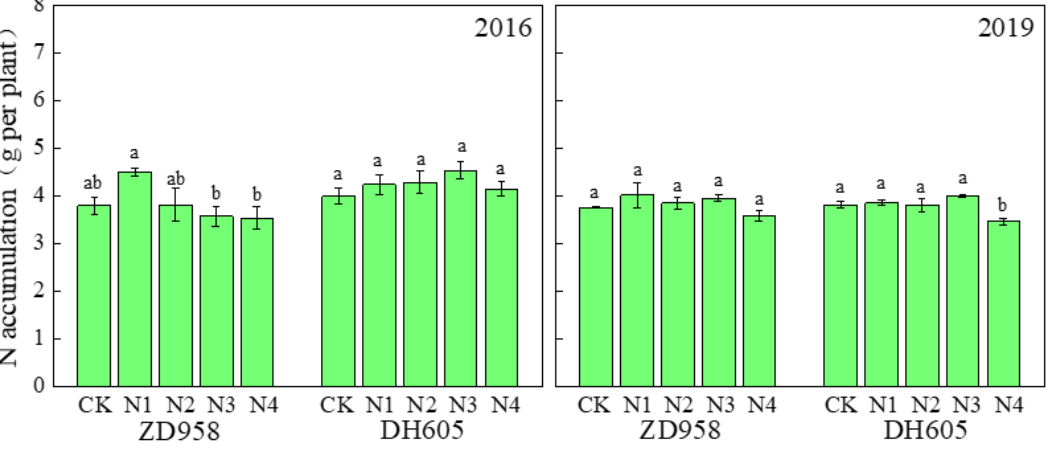
Figure 7. Effects of N treatments on total N accumulation in the R1 stage of maize in 2016 and 2019. Total N contents of the leaf and stem were examined. One-way analysis of variance with Duncan’s new multiple range test was conducted to assess the statistical patterns. Different letters indicate a significant difference ( p < 0.05). Table 4. Effects of N treatments on N harvest index, remobilized N, and N fertilizer partial produc- tivity.